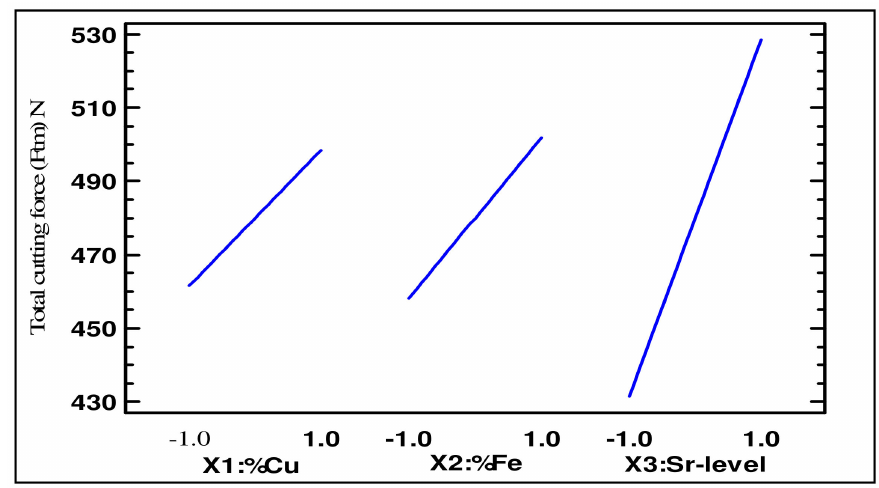
Figure 8. Main effects plots for total cutting force (F tm in N) as a function of Cu, Fe, and Sr content for heat-treated Al-11%Si alloys.